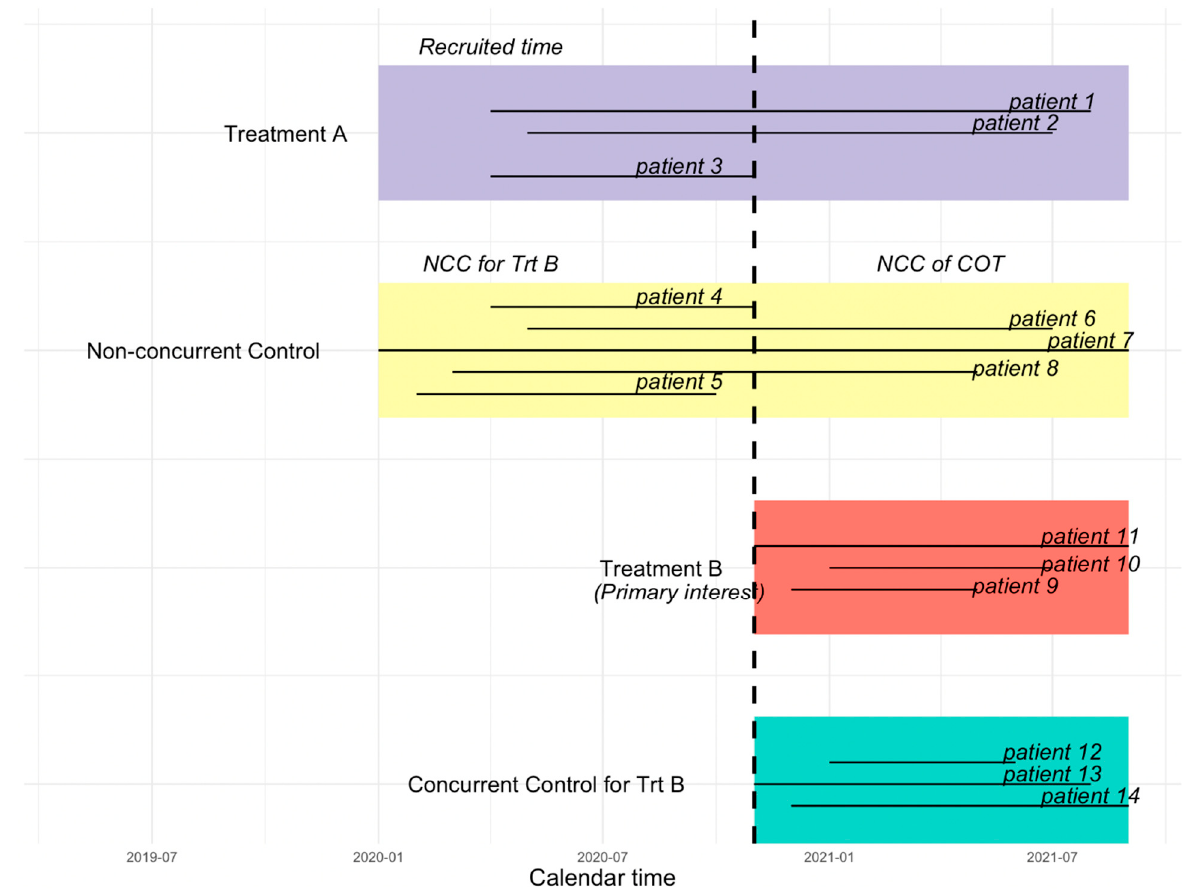
Figure 2. Non-concurrent control (NCC) and concurrent control (CC) in a platform trial. For sim- plicity, this platform trial only includes treatments A and B, with different entry times. Treatment A was investigated first, and then treatment B was added to the trial. The vertical dashed line represents the entry time of treatment B. Different color bars indicate different groups, and multiple lines within different color bars indicate different patients. For the evaluation of treatment B versus control, control patients recruited prior to the treatment B entry time are considered as non-concurrent control (yellow bar), whereas the control patients who are randomized concurrently with treatment B are considered as the concurrent control (CC) (green bar). Furthermore, within the non- concurrent control group, the observation time is divided into non-concurrent and concurrent ob- servation time by the vertical dashed treatment B entry time.